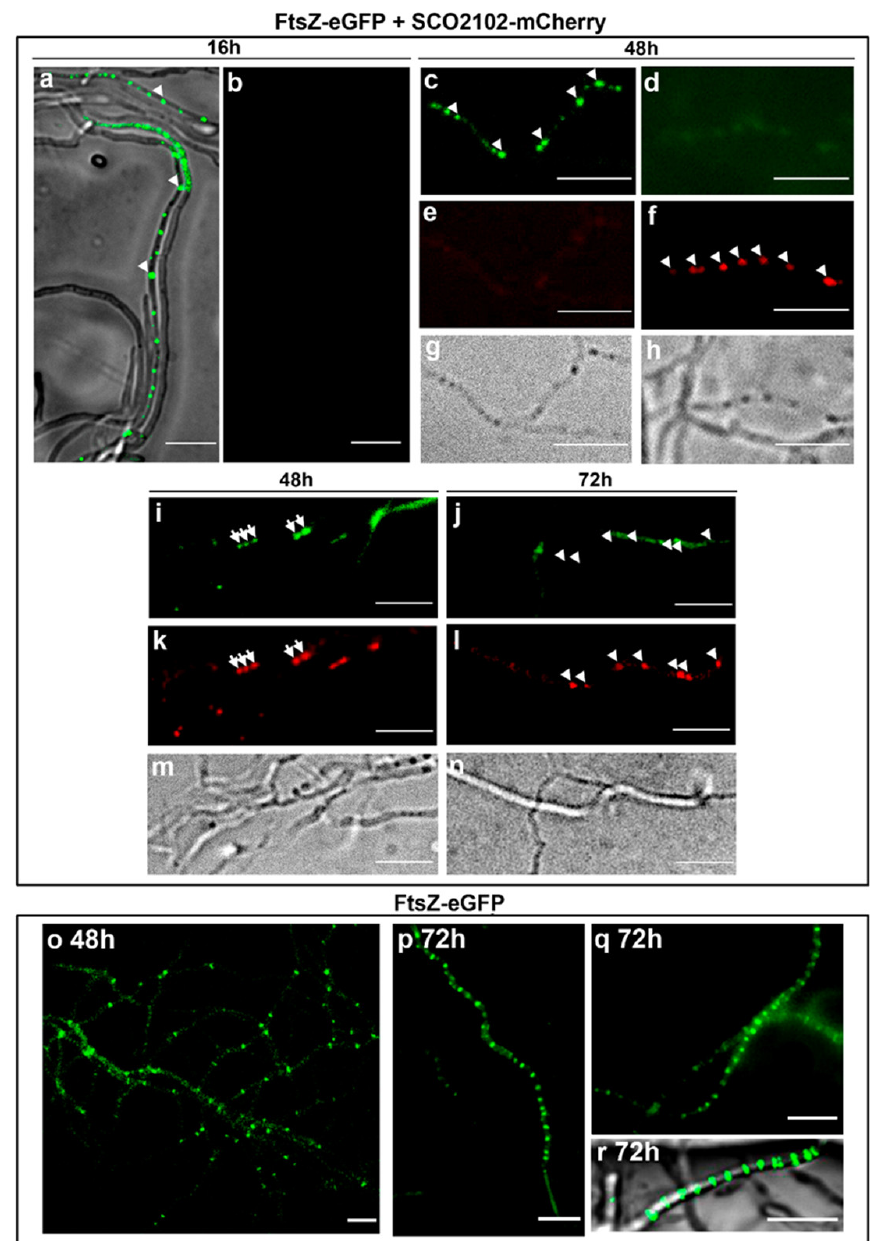
Figure 7. FtsZ-eGFP and SCO2102-mCherry dynamics in sporulating SFM solid cultures. ( a – n ) FtsZ- eGFP (green) and SCO2102-mCherry (red) co-expression and cellular localisation in SFM solid cultures. Arrows indicate co-localising FtsZ-eGFP and SCO2102-mCherry spots. Arrow heads indicate FtsZ-eGFP or SCO2102-mCherry spots that do not co-localise. ( o – r ) FtsZ-eGFP (green) expression in the S. coelicolor wild-type strain. Z-ladders are observed during sporulation (72-h culture). Fluorescence and phase-contrast microscope images are shown. Scale bars indicate 5 µ